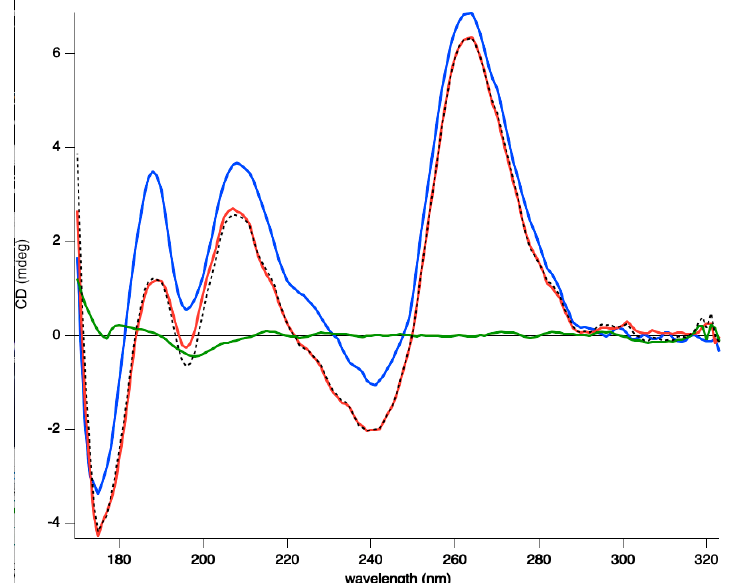
Figure 3. Synchrotron radiation circular dichroism (SRCD) analysis of the (G 3 T) 4 quadruplex complexed to Hfq-CTR. Spectra of (G 3 T) 4 in the absence (red) and presence of Hfq-CTR (blue). Hfq alone (green). The spectrum of the complex (blue) is similar to the sum of the (G 3 T) 4 and Hfq-CTR spectra (dotted black), differing only in the strength of its amplitudes. This signifies most likely that upon complex formation, an enhancement of already existing structural features in the quadruplex is occurring. It is not clear whether the Hfq-CTR in contact with (G 3 T) 4 changes its structure, to form amyloids, which would change the 210–220 nm amplitudes of the spectrum [38].